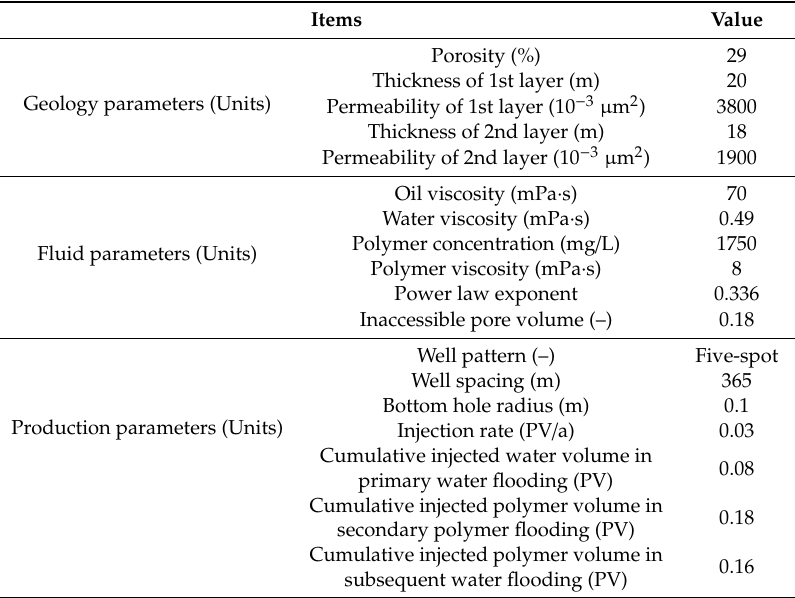
Table 2. Basic parameters of semi-analytical model calculation.